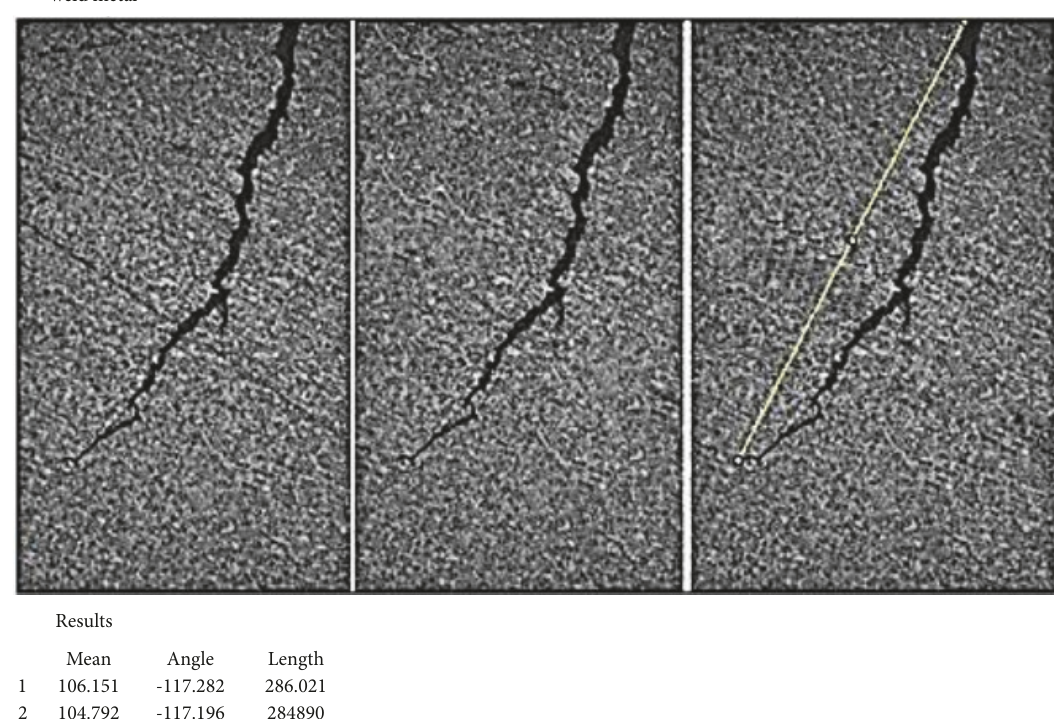
Figure 9: Results of crack depth stepwise measurement in the model sample with longitudinal weld